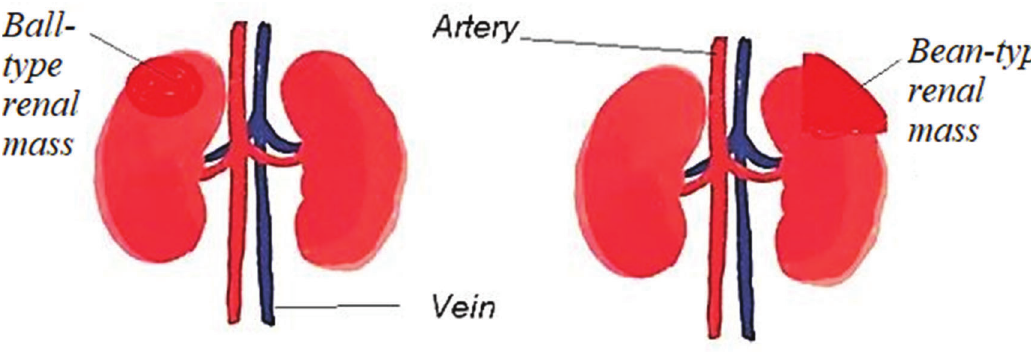
Figure 1 - Pictorial presentation of renal lesions. Ball-type and bean-type renal lesions.